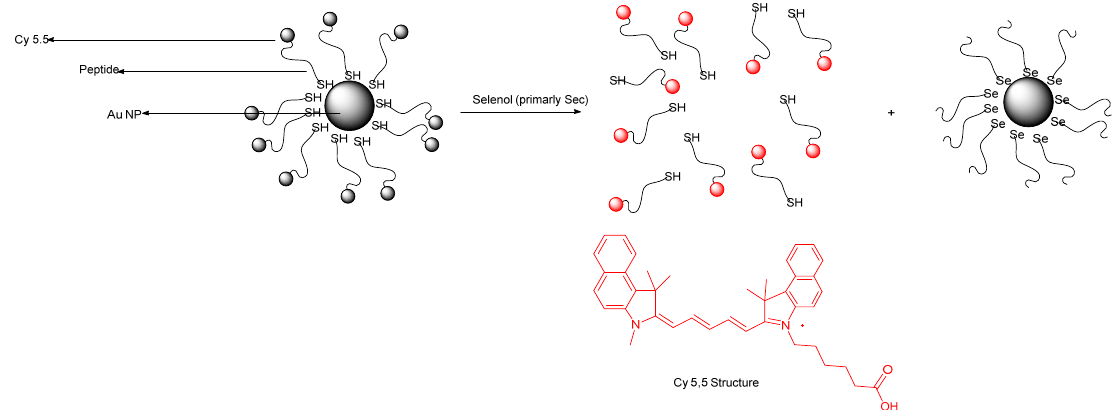
Figure 46. Molecular detection of selenol with gold nanoparticles and Cy–5,5 by Hu et al . Reduced Organic Selenium (Selenocysteine) (Biological)) e.g., H 2 Se